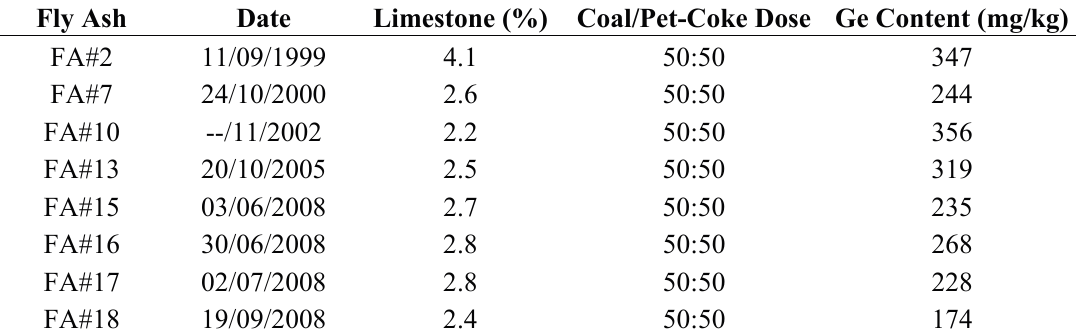
Table 1. Production date, limestone dosage (%), coal/pet-coke ratio and Ge content (mg/kg) in fly ash samples selected for Ge and Ga extraction tests [8]. Fly Ash Date Limestone (%) Coal/Pet-Coke Dose Ge Content (mg/kg) FA#2 11/09/1999 4.1 50:50 347 FA#7 24/10/2000 2.6 50:50 244 FA#10 --/11/2002 2.2 50:50 356 FA#13 20/10/2005 2.5 50:50 319 FA#15 03/06/2008 2.7 50:50 235 FA#16 30/06/2008 2.8 50:50 268 FA#17 02/07/2008 2.8 50:50 228 FA#18 19/09/2008 2.4 50:50